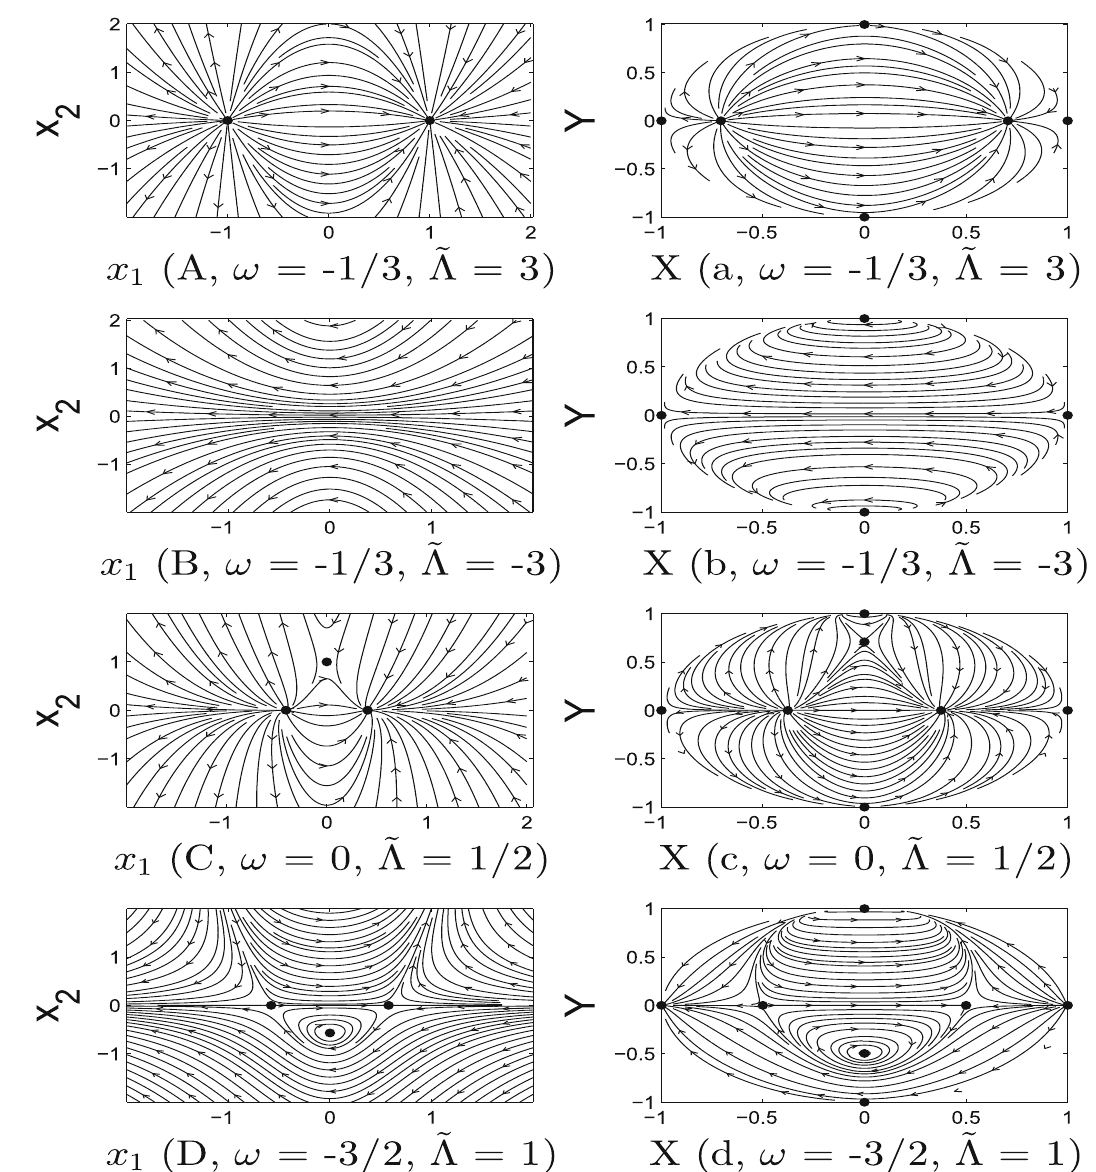
Fig. 8 Uncompact (left panel) and compact (right panel) phase por- x 2 respectively denote the dimensionless ˜ H and ˜ ρ as defined in Eq. (7). X and Y arethecoordinatesonthePoincarésphereasdefinedinEq.(47). traits when cosmological constant is included. Representative cases are (cid:11) (cid:12) (cid:11) (cid:12) (cid:11) (cid:12) The dotted circles represent fixed ω = − 1 ω = − 3 , ˜ (cid:4) = ± 3 ω = 0 , ˜ (cid:4) = 1 , ˜ (cid:4) = 1 and , . x 1 and 3 2 2